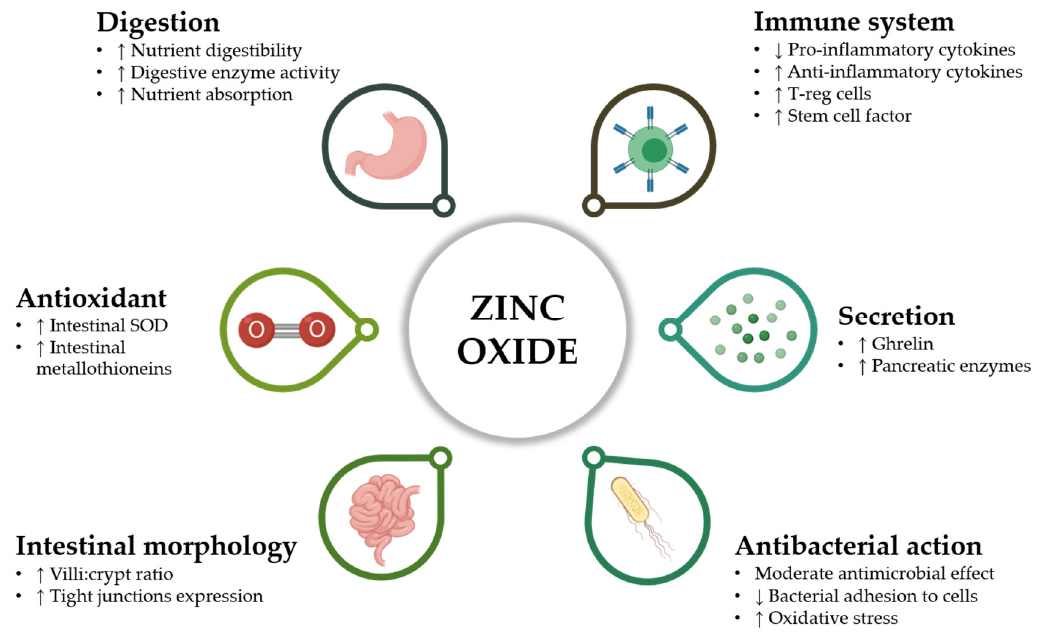
Figure 1. Beneficial effects and mechanisms of action of zinc oxide in post-weaning piglets. For each parameter, the up arrow “ ↑ ” means an increase, while the down arrow “ ↓ ” identifies a reduction.